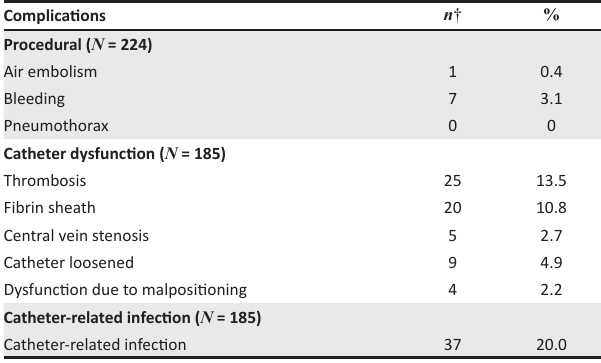
TABLE 3: Complications and incidence.